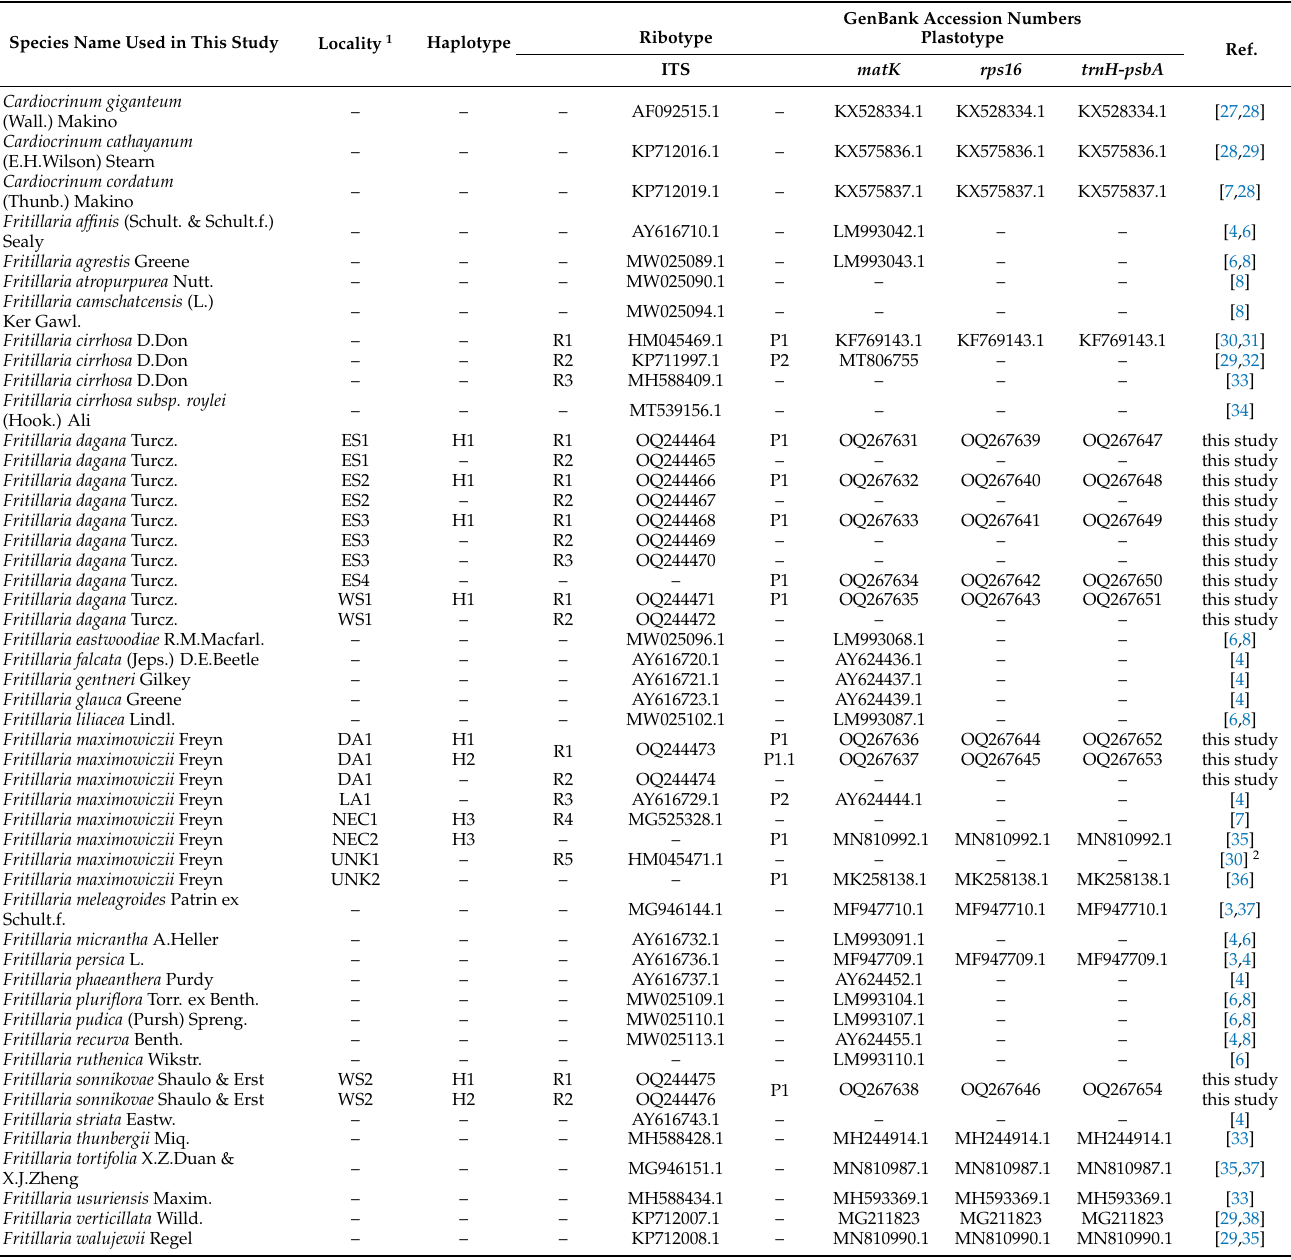
Table 2. The taxa and DNA sequences used for the phylogenetic